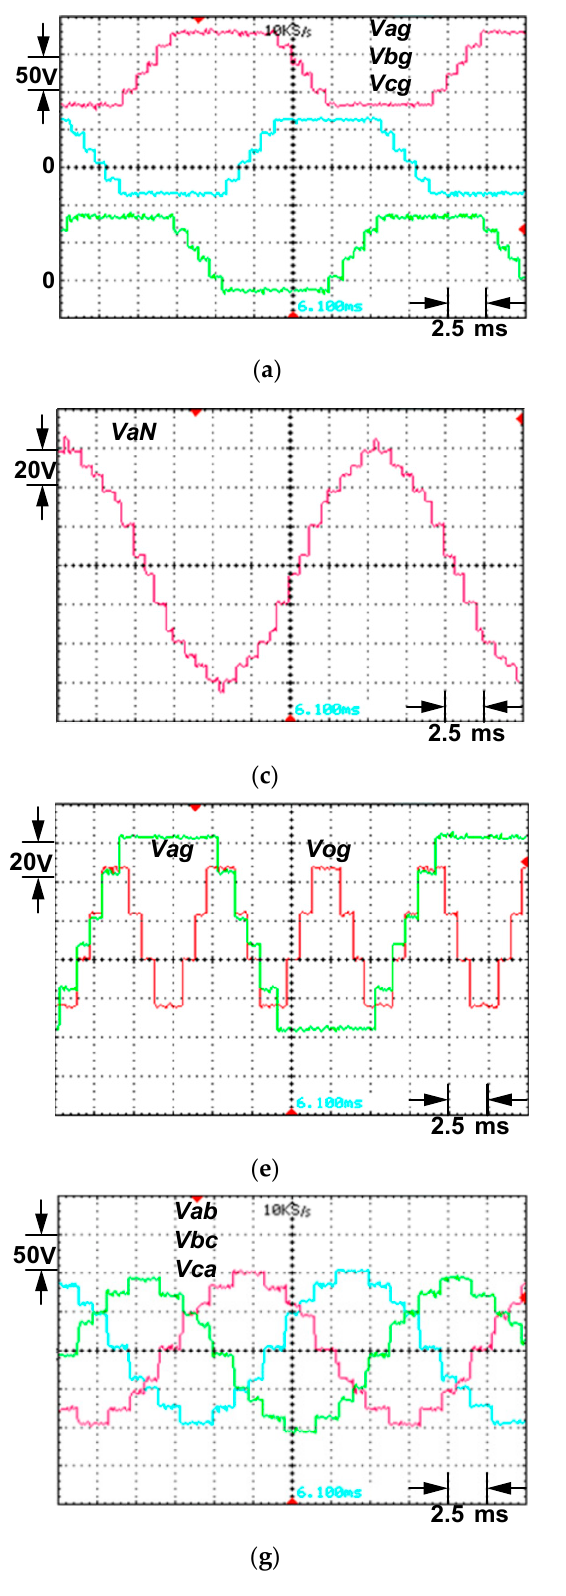
to mid-point voltage and ( e ) line to ground and mid-point ground voltages, ( f ) For Ma =1.15, line to line voltages, ( g ) For Ma = 0.98, line to line voltages, ( h ) For Ma = 0.8, line to line voltages.